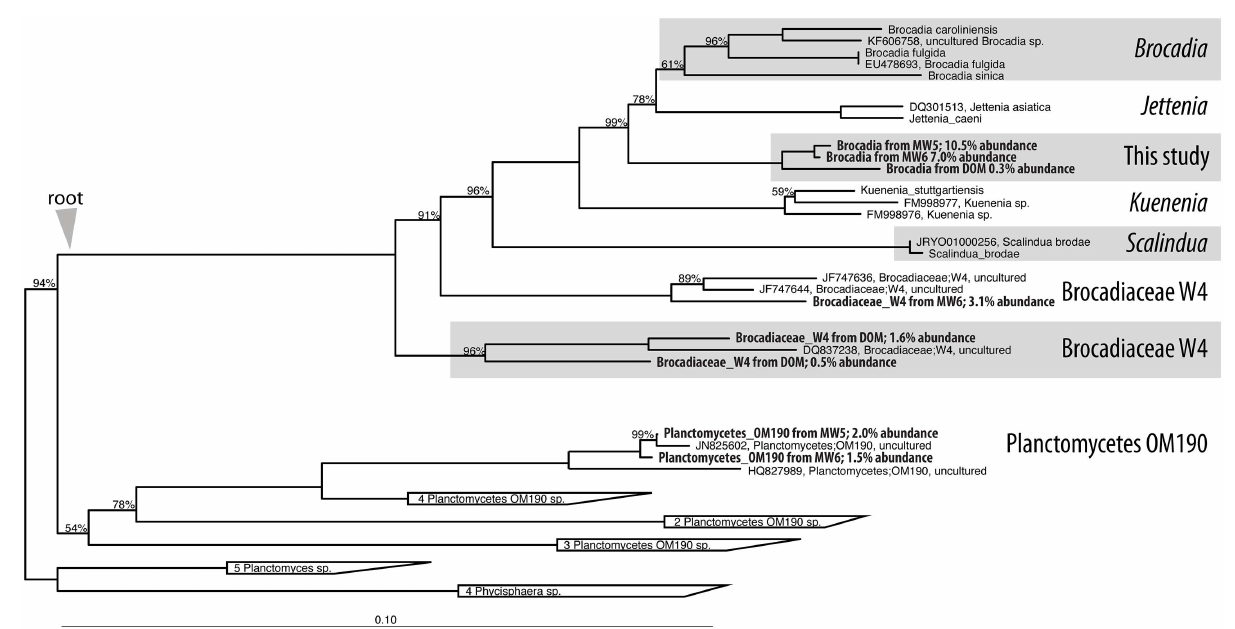
Fig 4. 16S phylogeny of the Planctomycetes on shows diversity within two distinct groups, the Brocadiaceae and the OM190 clade. Bold samples indicate they are from this study. Scale bar indicates10%